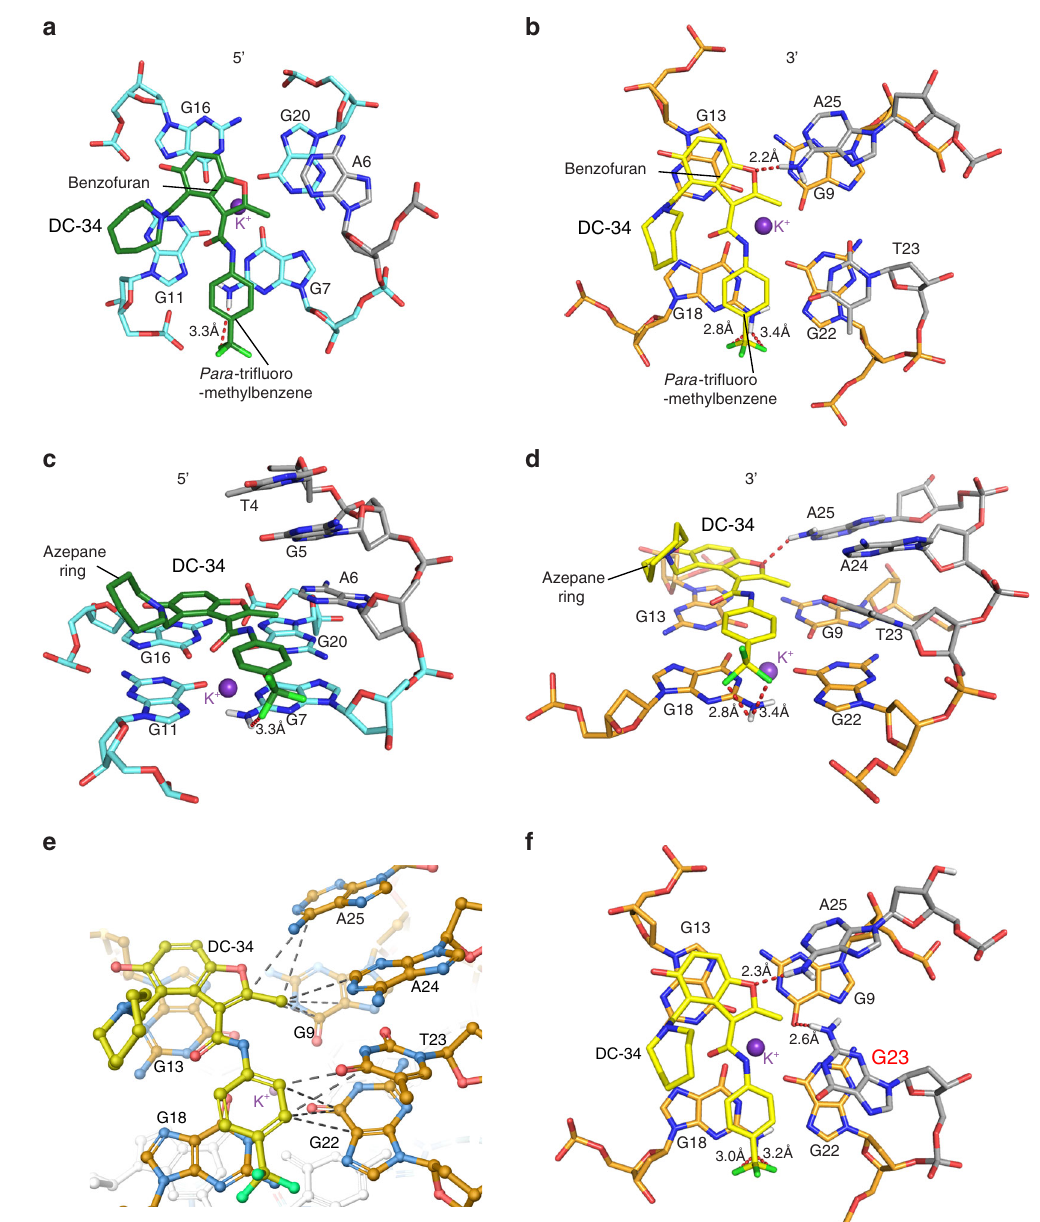
Fig. 8 Speci fi c contacts formed at each end of the MYC G4 provide a rationale for DC-34 as the preferred compound from the benzofuran-containing molecules screened. a – d Expanded views of the DC-34 /MYC G4 complex to display interactions at the 5 ′ ( a , c ) and 3 ′ ( b , d , e ) ends of the MYC G4. The color scheme follows Fig. 7 but with fl anking residues gray and oxygen, nitrogen and fl uorine in red, navy, and light green. Hydrogen bonds between MYC G4 and DC-34 are indicated by dotted red lines. In e hydrophobic contacts to fl anking residues are indicated by gray-dashed lines. f Expanded view of an energy minimized model structure of DC-34 /MYC G4 with wild-type guanine substituted for